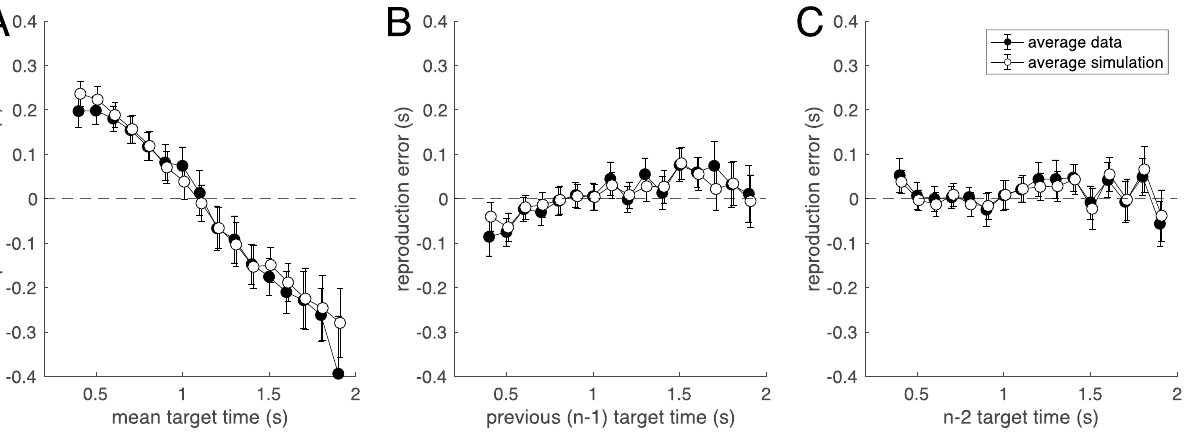
Figure 5. Average data for the duration reproduction experiment (black dots) together with average simulation result for the best fit iterative two-state model (open dots). Stimuli were presented in randomized order. ( A ) Reproduction error as a function of the current target duration (R 2 = 0.964). ( B ) Sequential dependence shown as reproduction error plotted over previous target duration (n − 1; R 2 = 0.803). ( C ) Reproduction error as a function of the target duration two trials in the past (n − 2; R 2 = 0.834). Data points are averages of 7 to 14 subjects (only 7 subjects received long durations above 1.7 s); error bars denote SEM. For the model simulation, the model (three free parameters) was fitted individually to the trial-by-trial time course of the responses of each subject (same fits as for Fig. 4). From theses individual simulated response time courses, the average simulation was computed in the same way as for the real response time courses. Note that not only average mean data and simulated responses match, but that also the size of the error bars is captured quite well by the